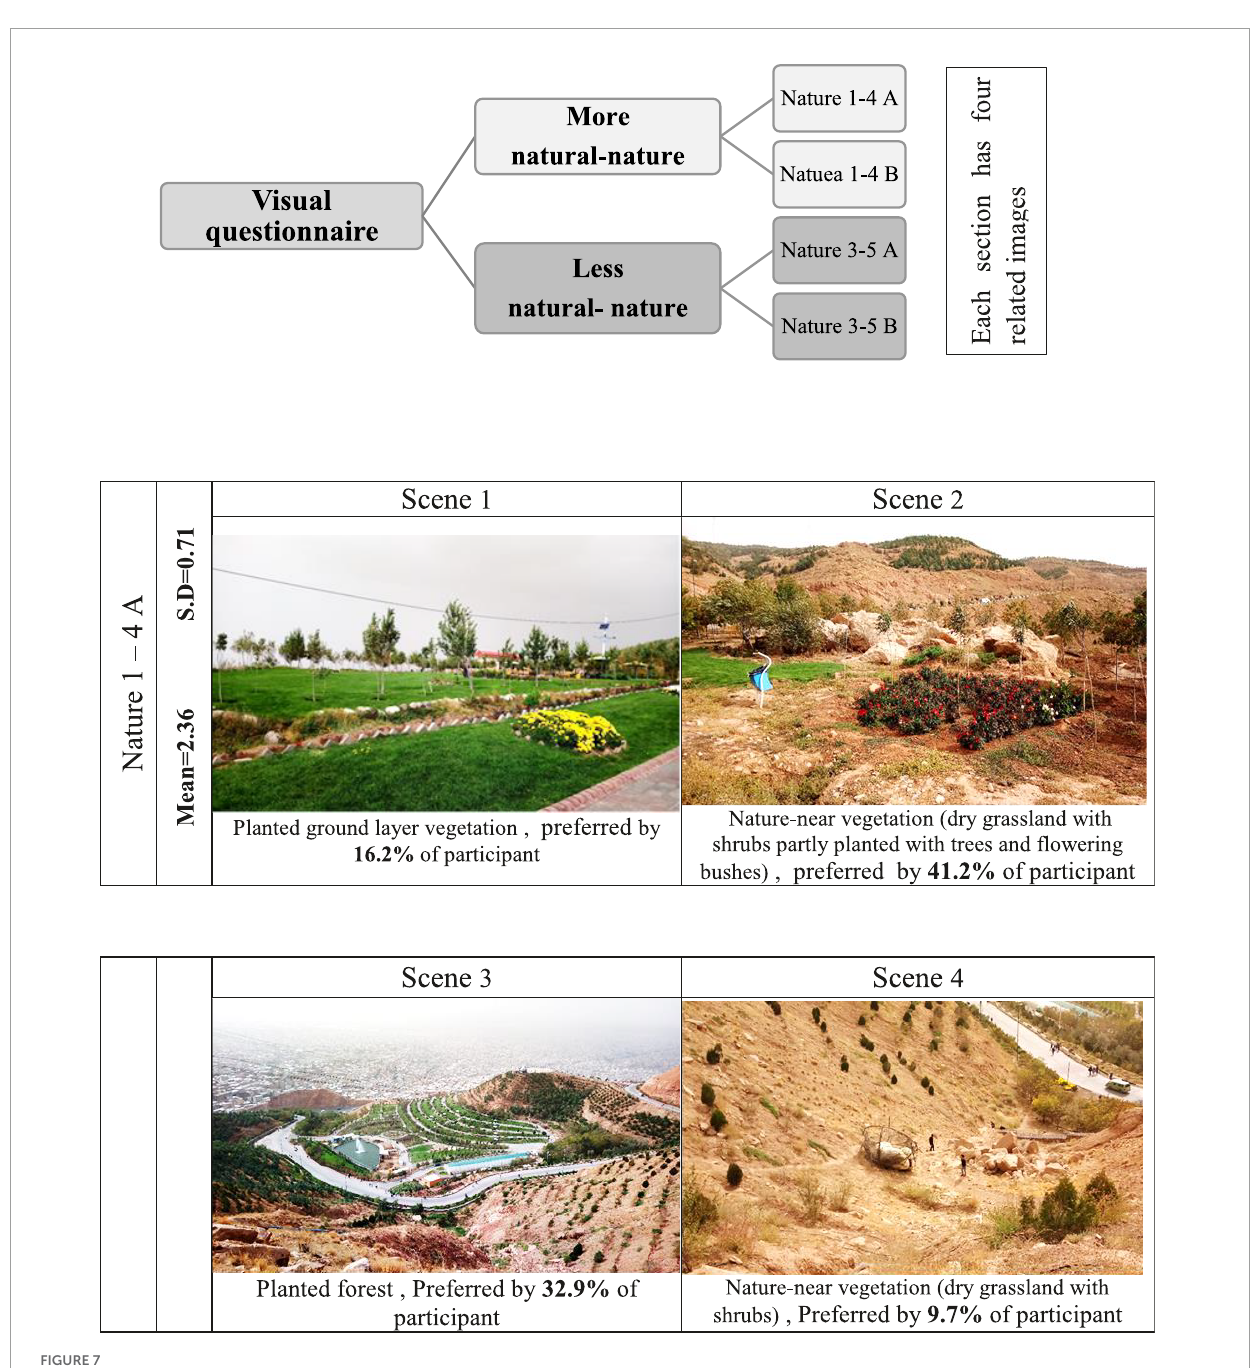
FIGURE7 The combination of “nature 1–4